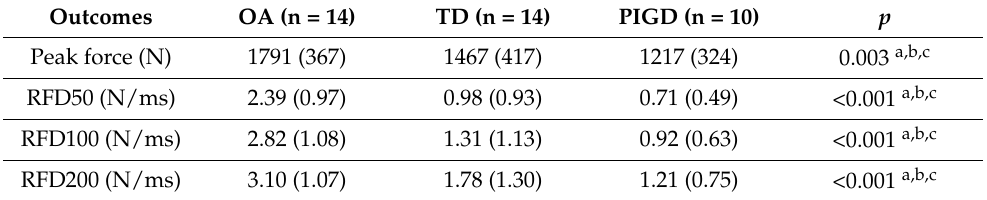
Figure 2. Representation of force versus time for each group and different rates of force developments (50 ms, 100 ms, and 200 ms). Data are mean (SD). OA: older adults; TD: tremor- dominant group; PIGD: postural instability and gait difficulty group. 4. Discussion We confirmed our hypothesis that people with PD would exhibit impaired force production when compared with OA. Lower peak force and RDF50, RDF100, and RDF200 were observed in people with PD, regardless of the subtype, compared to OA. Even after controlling for covariates, such as age, sex, BMI, and HY stages (for PD only), these results remained the same. Regarding our hypothesis, the PIGD subtype would exhibit impaired